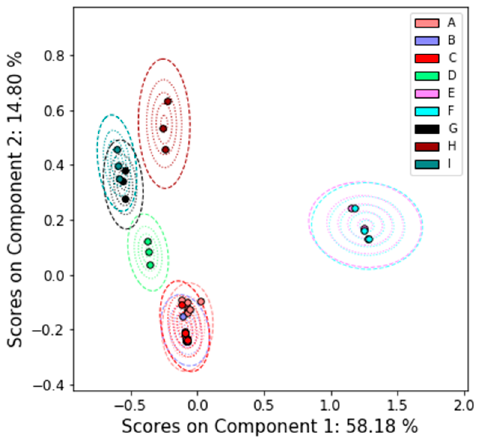
Figure 3. PCA results with uncertainty analysis on all of the ILS’s NMR data. The PCA scores are superimposed on contours of the T 2 distance. Dotted contours correspond to the 5%, 25%, 50%, and 75% confidence limits. The dashed contour corresponds to the 95% confidence limit.